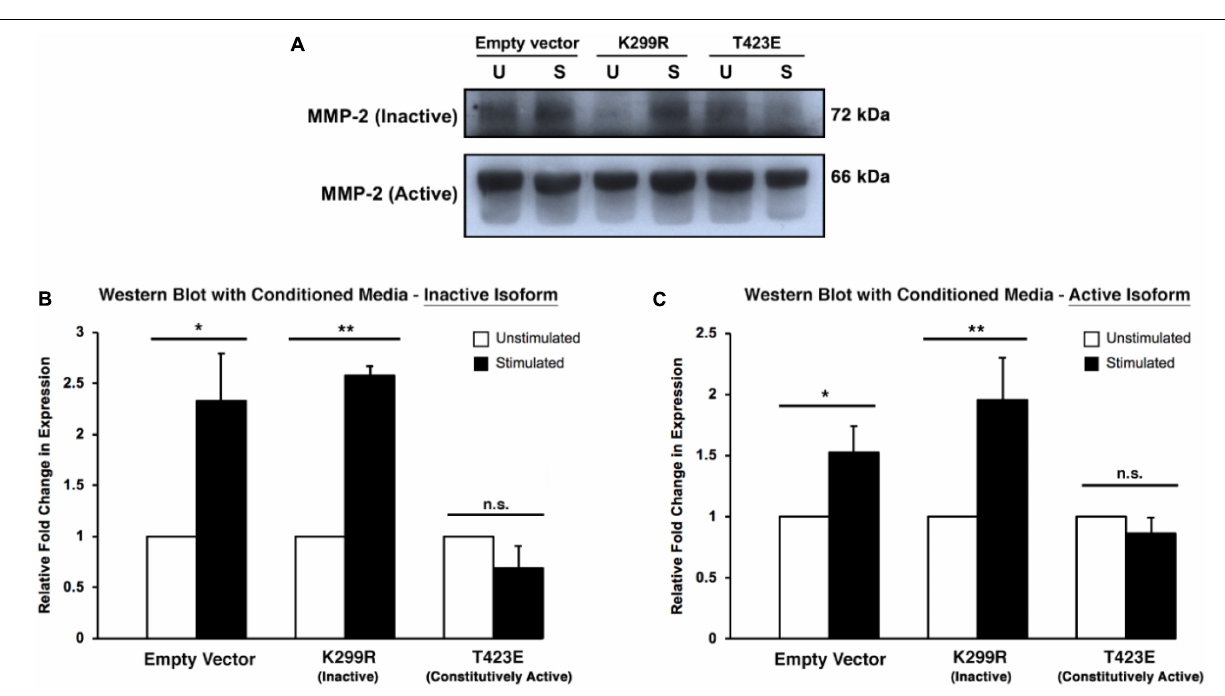
FIGURE 6 | Overexpression of kinase-dead PAK1 promotes more MMP-2 secretion in response to mechanical stimulation. (A) A representative western blot of PAK1 mutants (K299R: kinase inactive; T423E: constitutively active) and inactive/active MMP-2 isoforms. (B) When PAK1 is made inactive, there is more inactive MMP-2 secretion with stimulation compared to overactive PAK1. (C) With stimulation, a less active PAK1 causes a significant increase in MMP-2 section of the active isoform. If PAK1 is constitutively active, no change in MMP-2 secretion occurs with stimulation. ∗ P < 0.05, ∗∗ P < 0.01 by Student’s t -test; n = 3. Error bars represent the